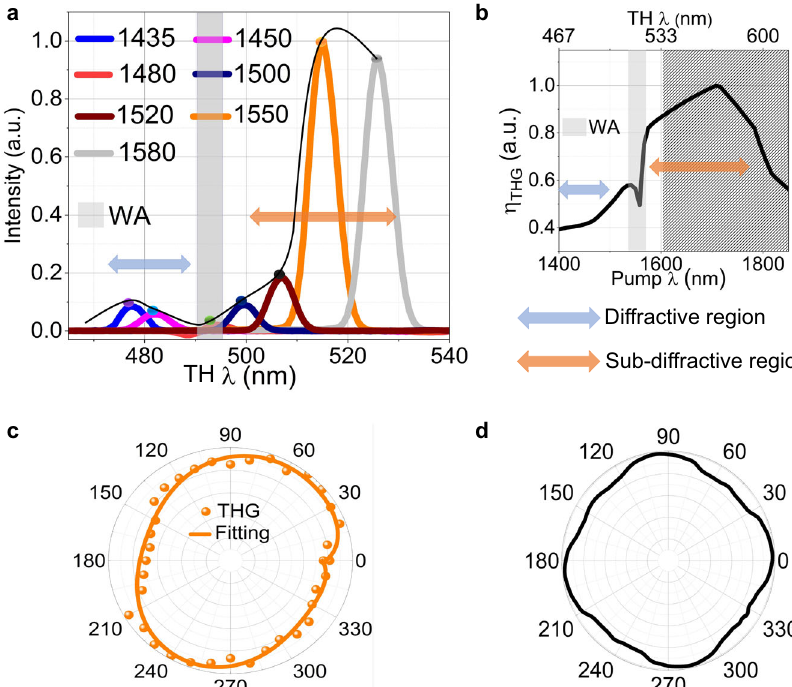
Fig. 4 Third harmonic generation enhancement in a TMDC metasurface. a Measured wavelength-dependent third harmonic response in forward direction for metasurface C. The shaded region represents Wood ’ s anomaly WA. b Simulated third harmonic conversion ef fi ciency η pump wavelength, of MoS 2 truncated cone metasurface C. The patterned region represents the spectrum range not accessible by the laser in our experimental setup. c Experimental polarisation resolved third harmonic generation THG of metasurface C, at a pump wavelength of 1550 nm. d Simulated polarisation resolved THG of metasurface C, pump wavelength 1550